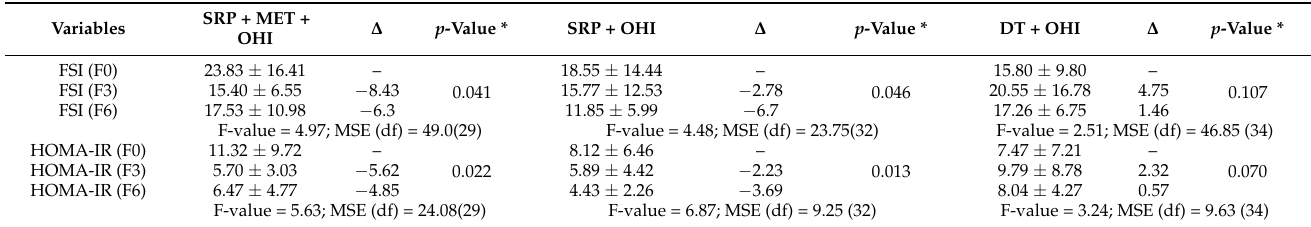
Table 2. Post-intervention within-group mean differences in glycemic variables.